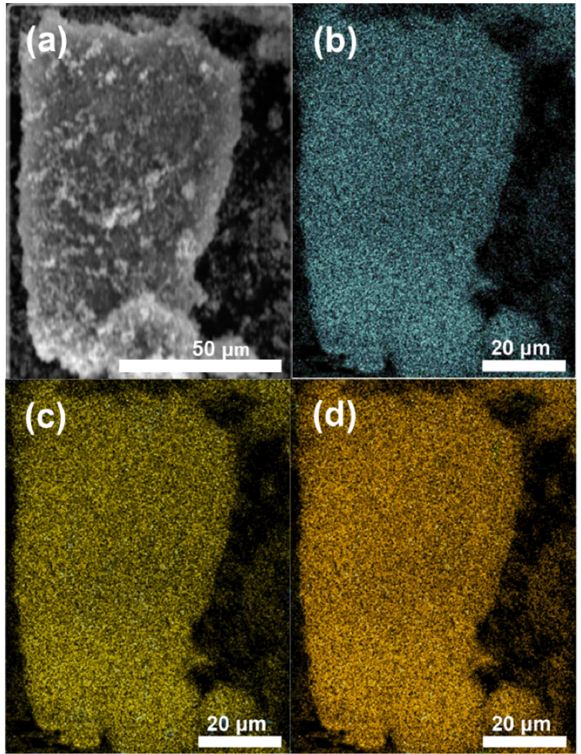
Figure 3. ( a ) SEM and mapping images of ( b ) Ti, ( c ) F and ( d ) Au elements on Au/F-TiO 2 (n F :n Ti = 2.5).